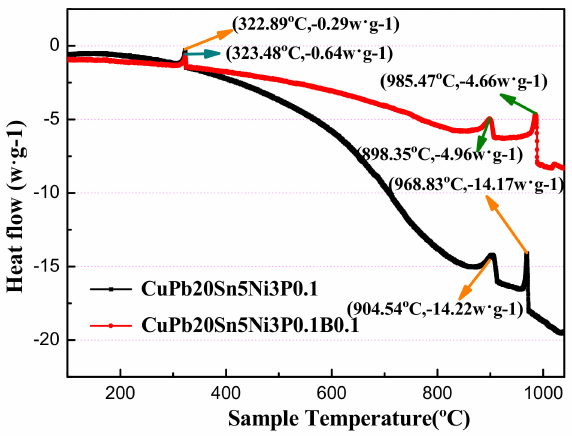
Figure 6. DSC of the ZCuPb20Sn5P0.1-xB